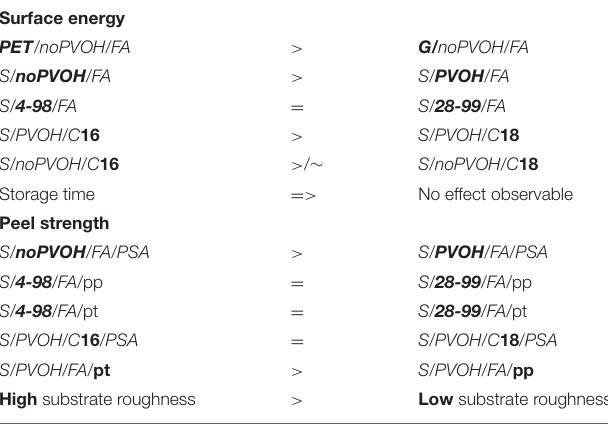
TABLE 3 | Summary of results. Surface